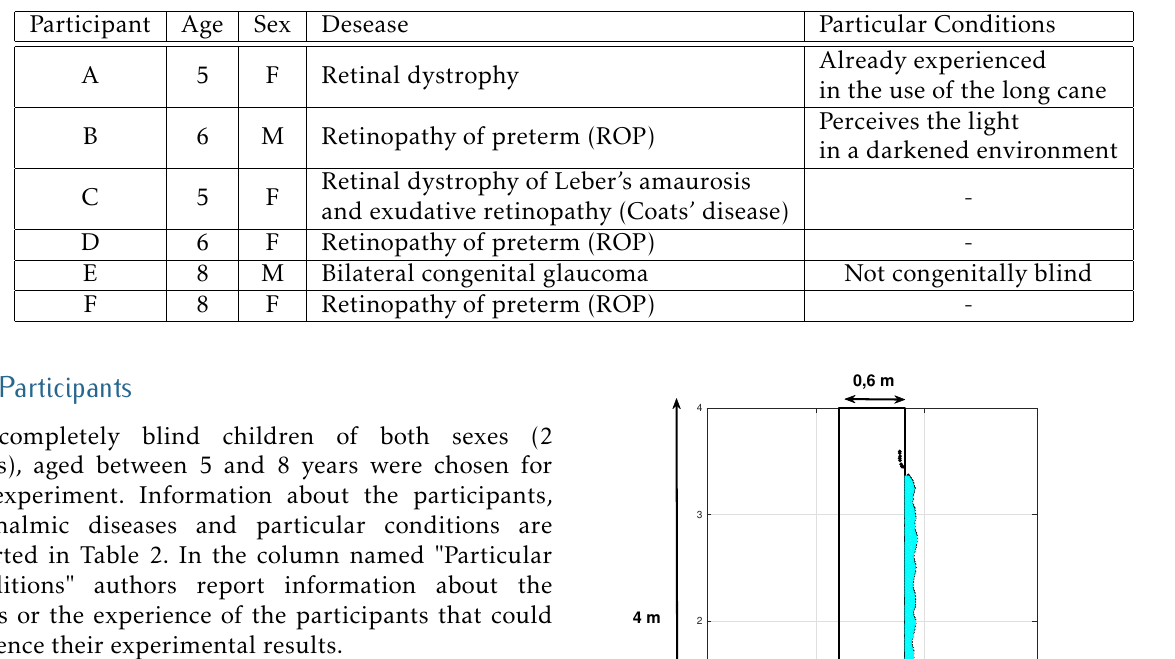
Table 2. Experiment participants’ information